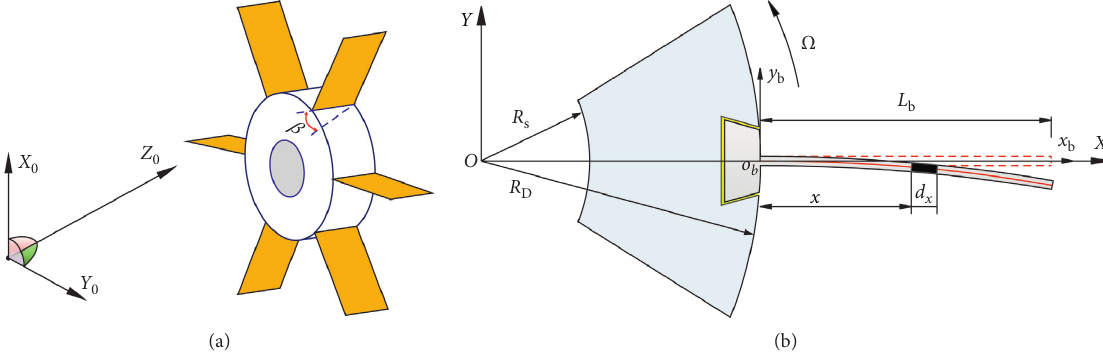
Figure 1: (a) Schematic diagram of a disk-beam structure. (b) A single sector of the disk-beam system with the dovetail interface